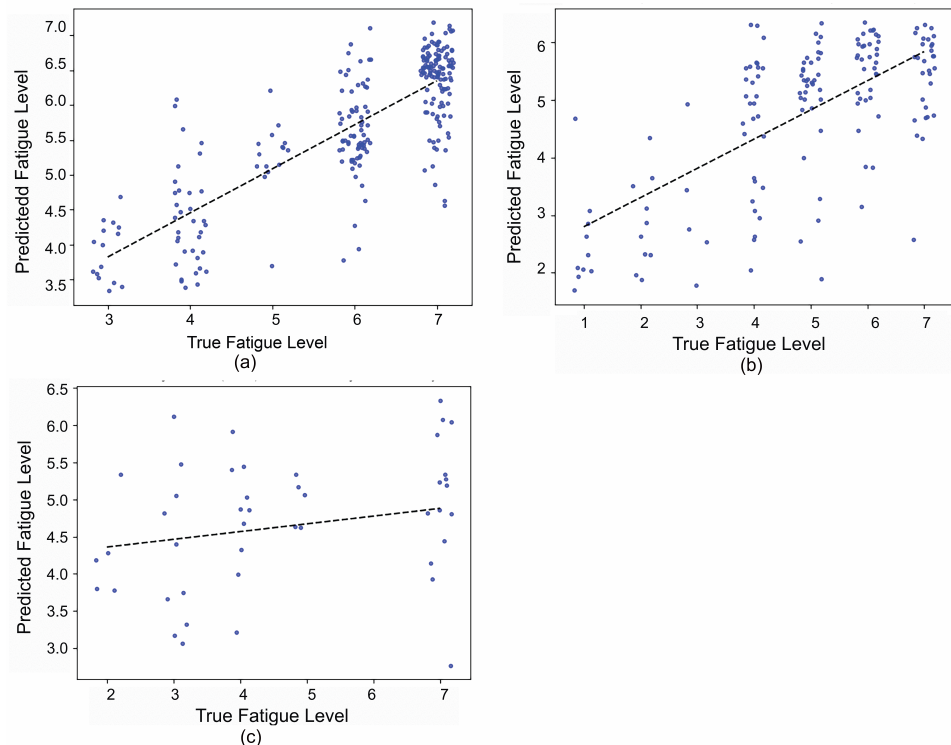
Figure 7. The predicted results of example subjects based on squat motion data from the FP representing the correlation between the predicted fatigue level and self-reported fatigue level ( a ) Subject 2 (strong correlation), ( b ) Subject 5 (moderate correlation), ( c ) Subject 8 (weak correlation).